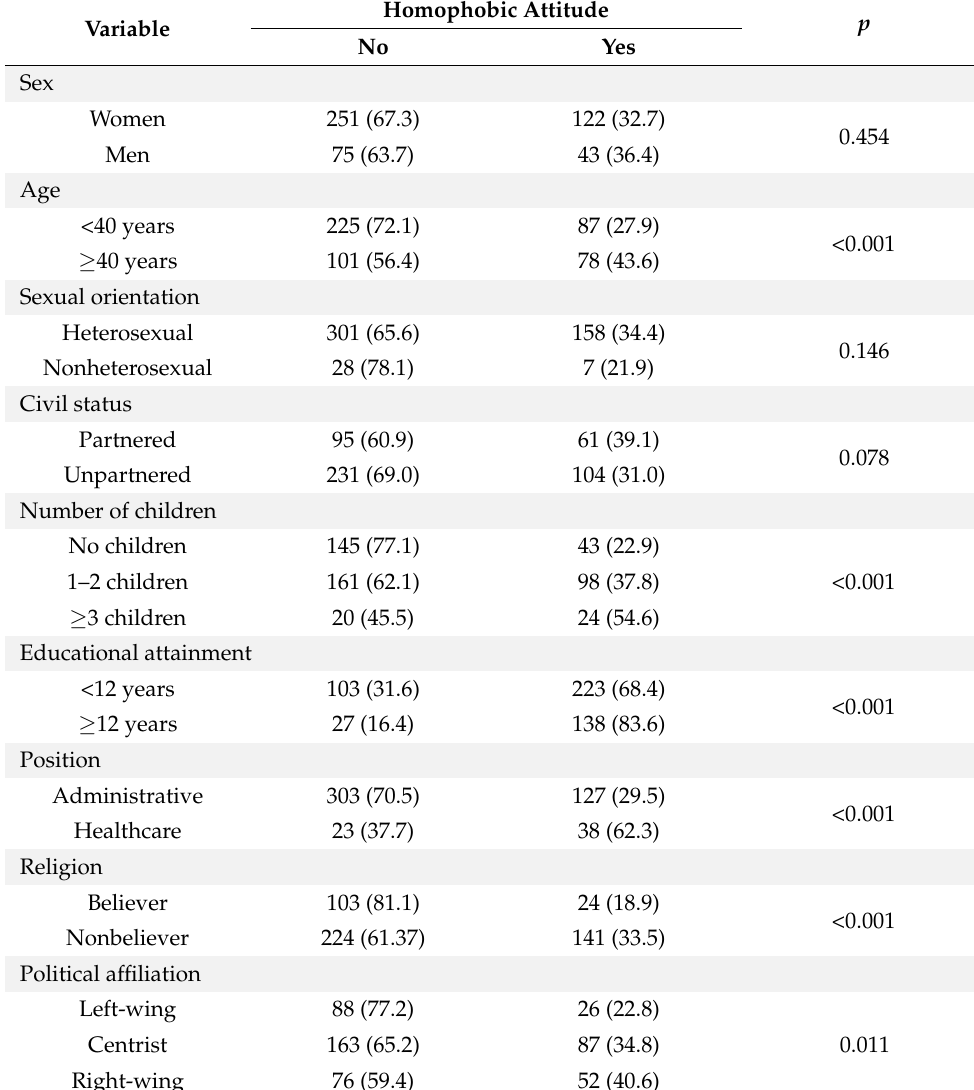
Table 2. Bivariate analysis of presence of homophobic attitudes according to sociodemographic characteristics.